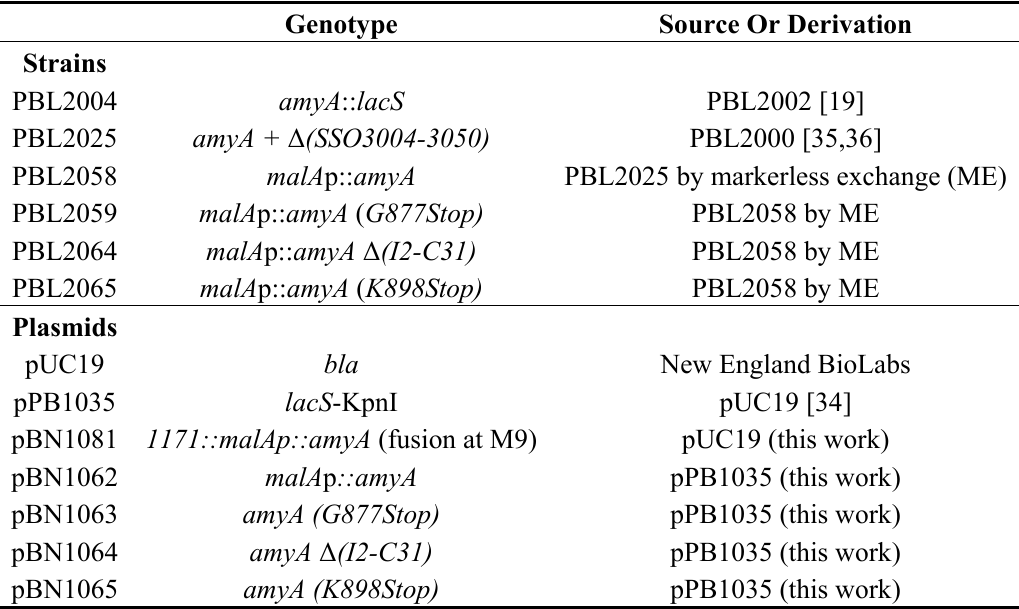
Table 1. Archaeal strains and